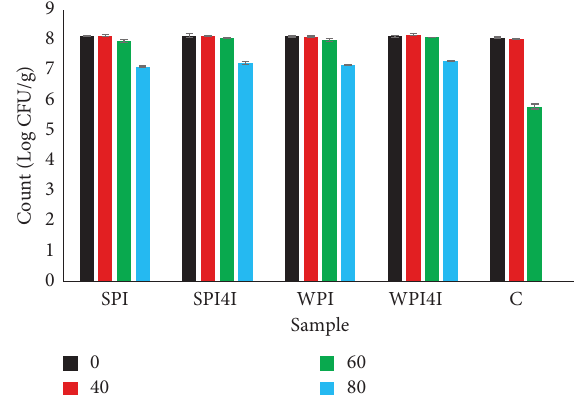
Figure 2: Effect of heating (0, 40, 60, and 80 ° C) on the viability of L. reuteri encapsulated within different wall materials (SPI: soy protein isolate 20%, SPI4I: soy protein isolate 20% +inulin 4%, WPI: whey protein isolate 20%, WPI4I: whey protein isolate 20% +inulin 4%, C: free bacteria).